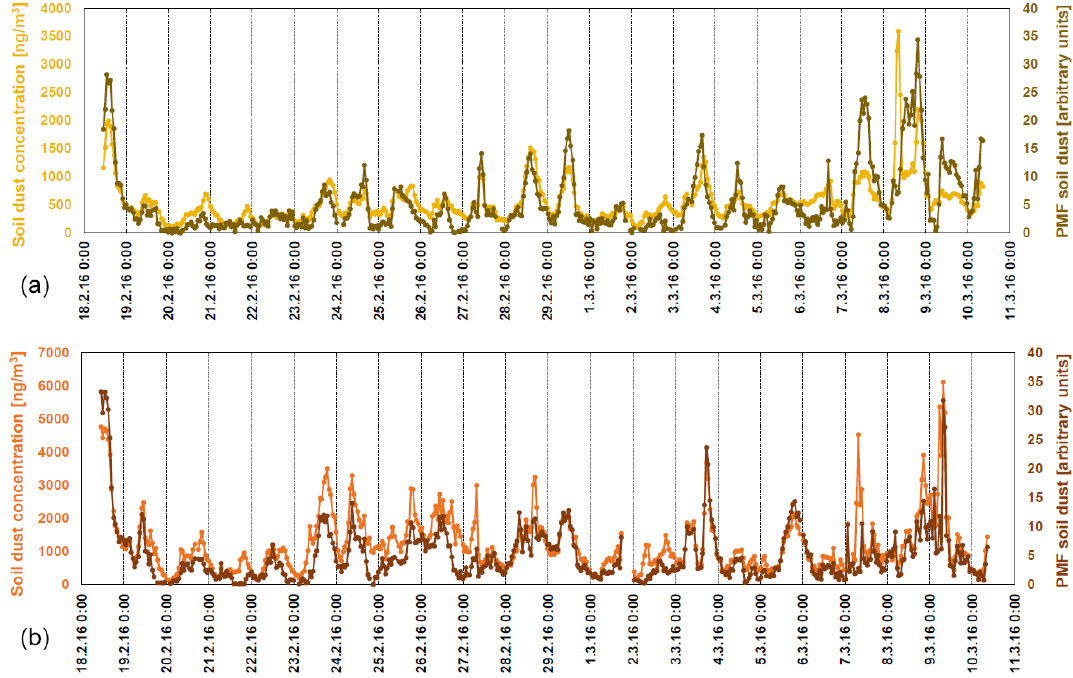
Figure 9. Hourly time series of the soil dust source contributions identified by PMF analysis (dark colors) and calculated soil component concentrations (light colors) in the fine (a) and coarse (b)